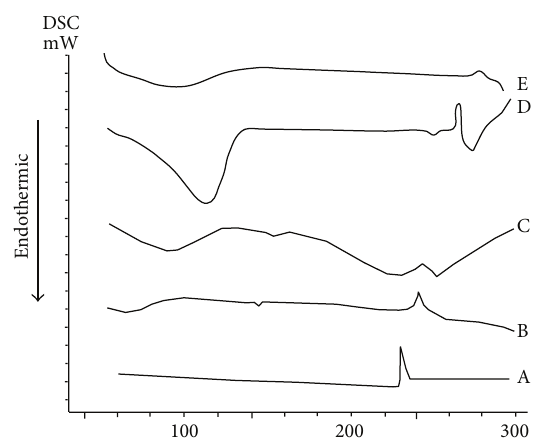
Figure 3: DSC thermograms of (a) LOR, (b) LOR-HPMC, (c) LOR- carpobol, (d) LOR- 𝛽 -CD, and (e) LOR- HP 𝛽